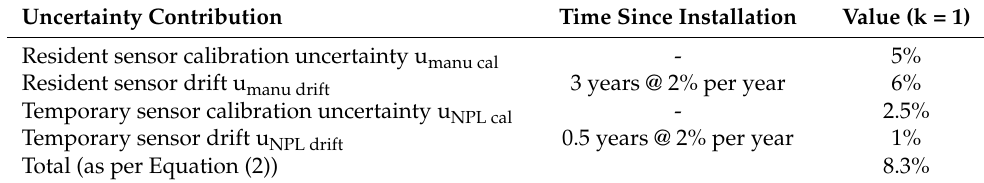
Table 2. Paired sensor uncertainty